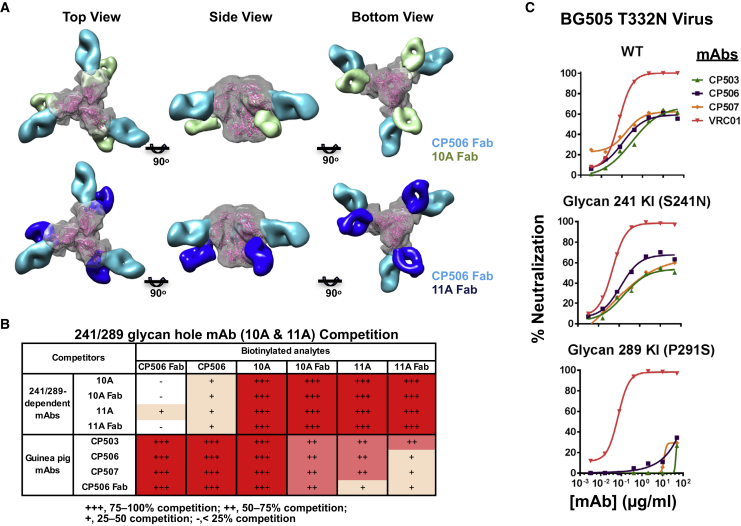
CP506 Epitope Is Different from the Glycan Hole-Recognizing NAbs Identified Previously(A) Comparison of the mode of CP506 binding to BG505 SOSIP.664 trimer with rabbit antibodies 10A (EMDB: EMD-8312) and 11A (EMDB: EMD-8311), which recognize the 241/289 glycan hole.(B) Non-reciprocal competition between CP506 Fab and 10A or 11A Fab shown by competition ELISA. Data were generated in duplication with reactions of CP506 Fab repeated at least twice.(C) The BG505 241 glycan knockin (KI) mutation, S241N, has no effect on virus neutralization sensitivity to CP506 lineage NAbs, while the 289 glycan KI mutation P291S abolishes neutralization sensitivity. Viruses with BG505 T332N background were tested. WT, wild-type. VRC01 is used as control antibody. Data were generated in duplication, with the mean of the percentage of neutralization shown.